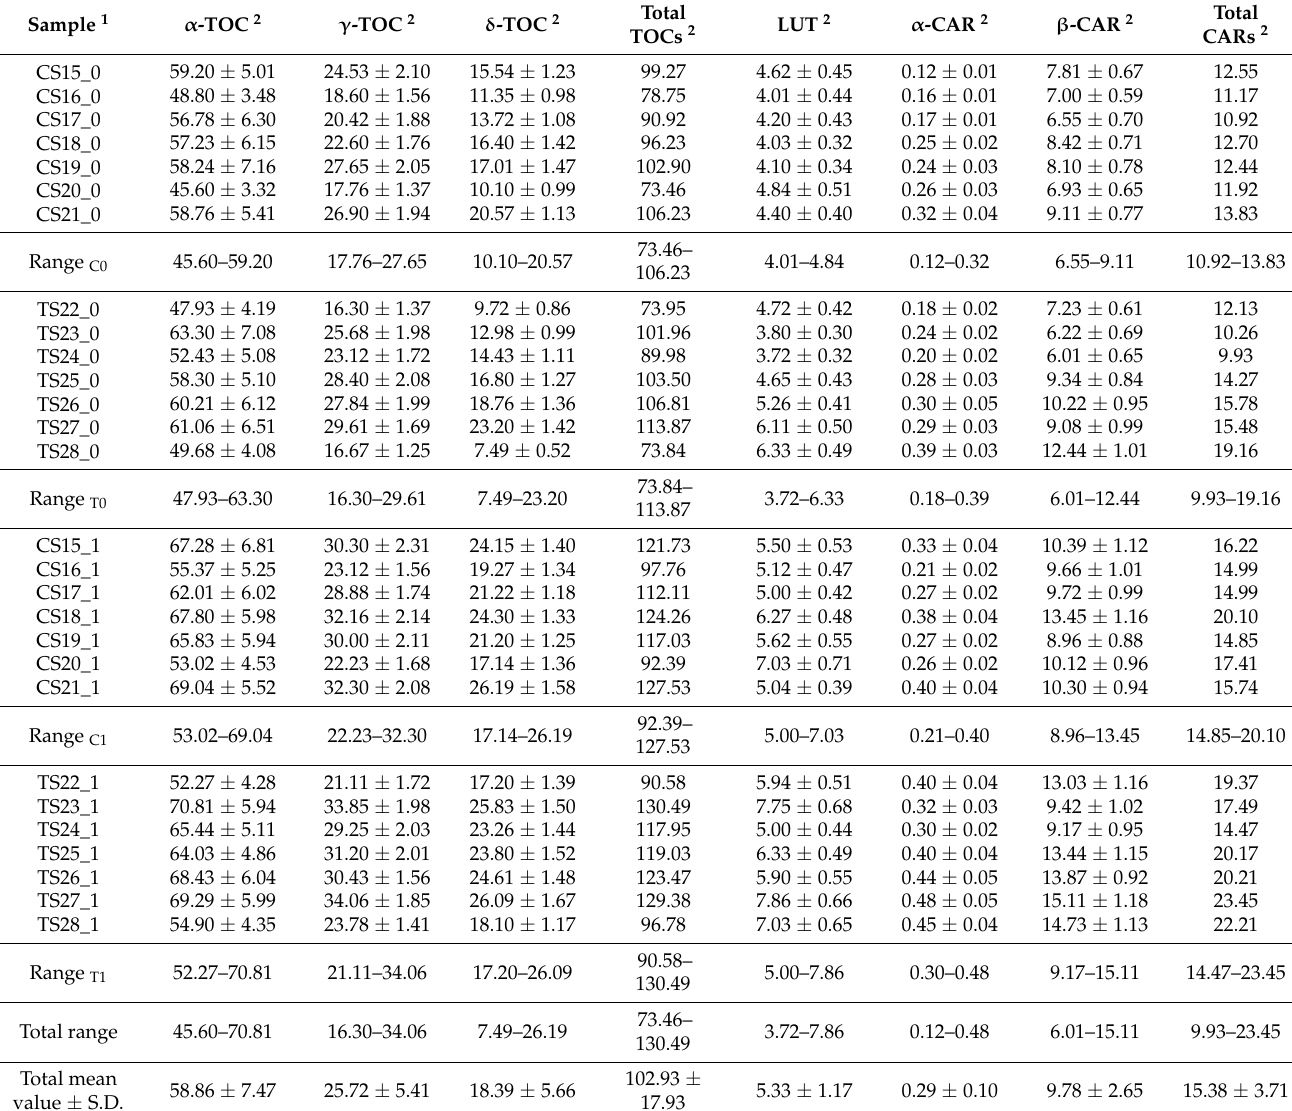
Table 2. Occurrence of tocopherols ( α -, δ -, and γ -tocopherol) and carotenoids ( α -carotene, β -carotene, and lutein) in “Ragusano” cheese samples produced in spring. Concentrations (mg /kg fresh weight) of single compounds are expressed as mean ± s.d. ( n =